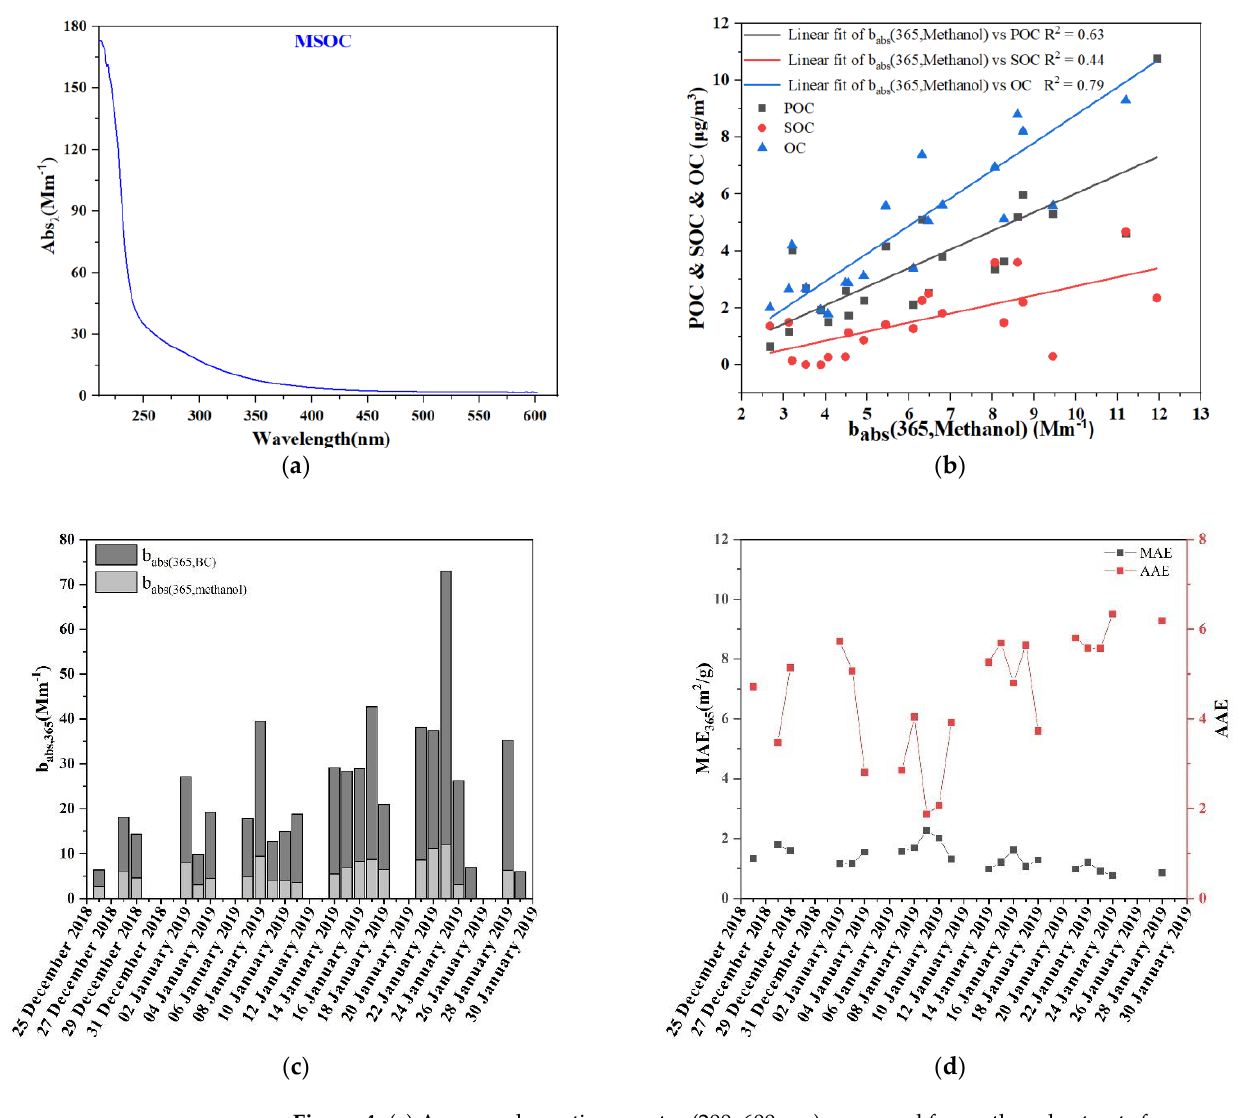
Figure 4. ( a ) Average absorption spectra (200–600 nm) measured for methanol extracts from samples; ( b ) relationship between the light absorption coefficient at 365 nm for methanol extracts and POC, SOC, OC; ( c ) daily variation of b abs (365, methanol) for the methanol extracts and b abs (365, BC) estimated for uncoated BC; and ( d ) daily variations of the AAE and MAE365 values for methanol extracts. The AAE of MSOC varied between 1.88 and 6.34 with a mean value of 4.58.